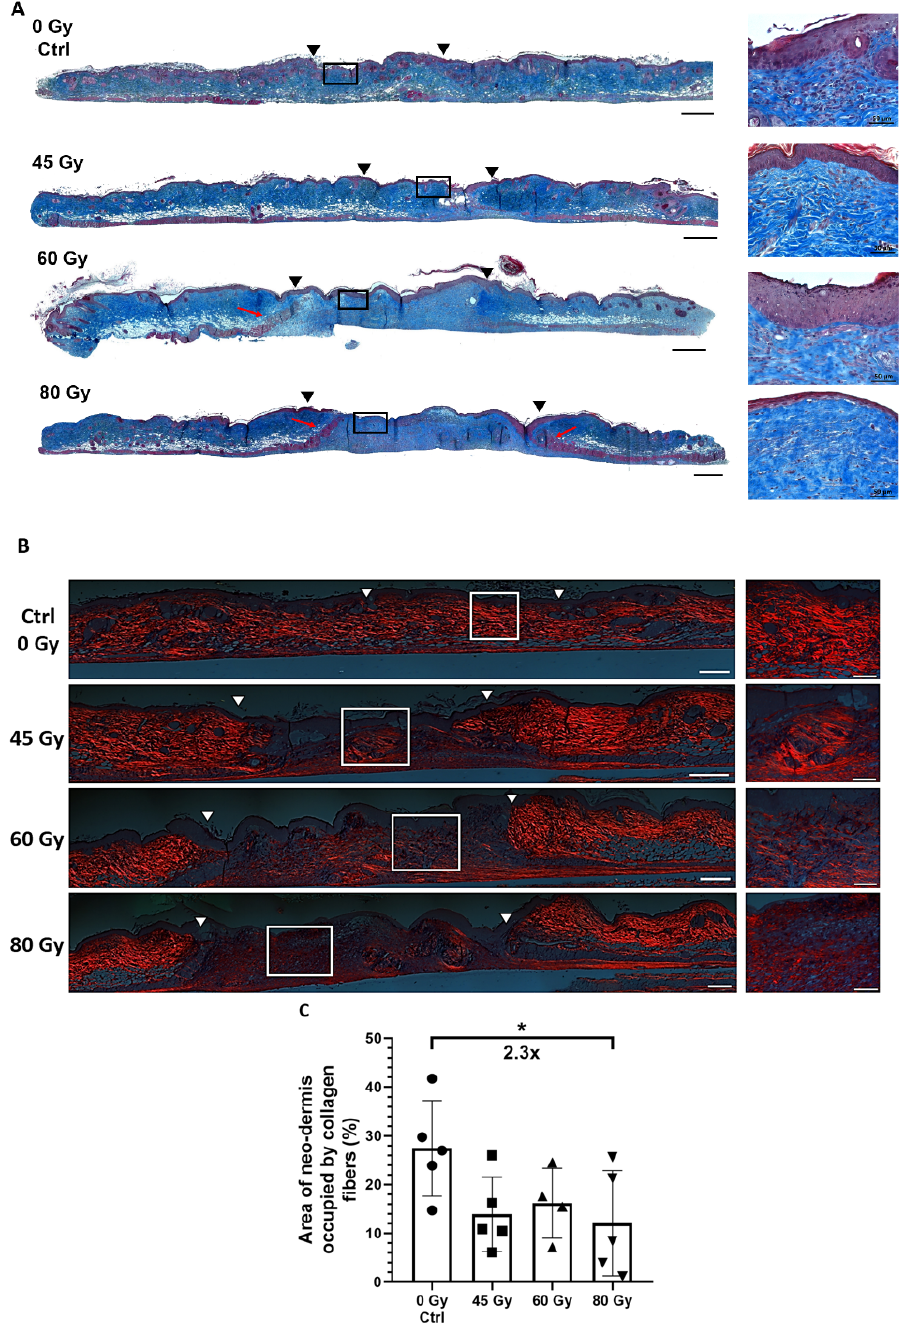
Figure 8. Appearance of the scar tissues after 33 days of healing. ( A ) Masson’s trichrome staining of representative transverse sections of scar and adjacent tissues 33 days after excisional surgery performed on normal or irradiated skin. The margins corresponding to the site of the initial punch biopsy are indicated by arrowheads. Red arrows show the emergence of the underlying muscle into the dermis. Bars = 500 µm. Images on the right are magnifications of the corresponding boxed areas shown on the left. Bars = 50 µm. ( B ) Images of the wounds after Picrosirius red staining of contiguous paraffin-embedded tissue sections. Bars = 500 µm. Images on the right are magnifications of the corresponding boxed areas shown on the left. Bars = 50 µm. ( C ) Percentage of the granulation tissue area, identified by white arrowheads in B, occupied by collagen fibers. Statistics: mean ± SD. n = 4–5 mice/group, One-way ANOVA with Dunnett’s multiple comparisons test * p < 0.05. * Symbol indicates significance between control and other groups.